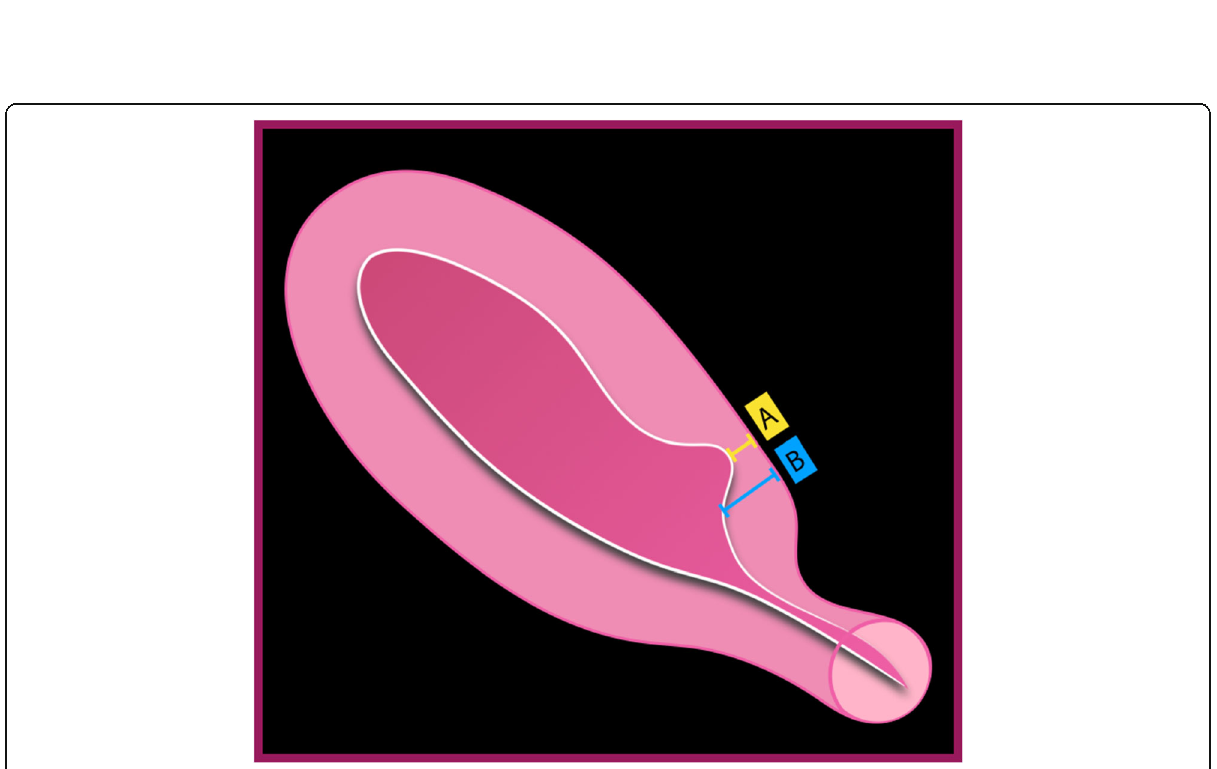
Fig. 10 CSD classification and calculation of remaining myometrium. A = thickness of remaining myometrium; B = full-thickness adjacent to defect. Percentage of myometrium remaining: x ð % Þ ¼ A